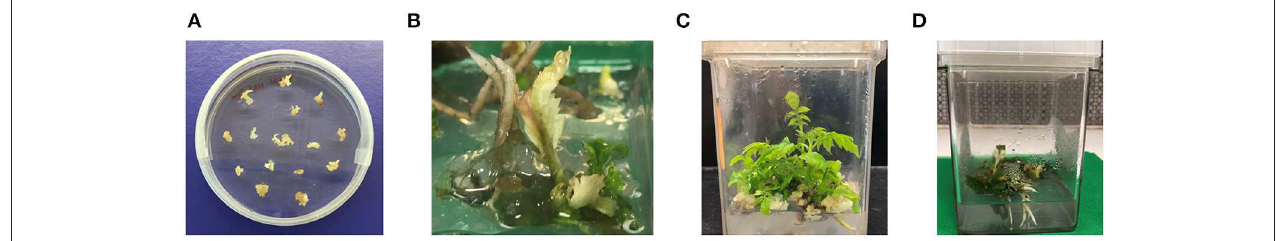
FIGURE 3 | Phenotype of edited lines. (A) Walnut somatic embryos maintained in vitro were transformed by Agroinfection and kept in selective DKW medium containing hygromycin. Surviving embryo lines were transferred to shoot-inducing medium and phenotypes of resulting (B) stunted/albino, and (C) normal shoots were observed. (D) PDS inactivated lines also displayed vigorous root formation.